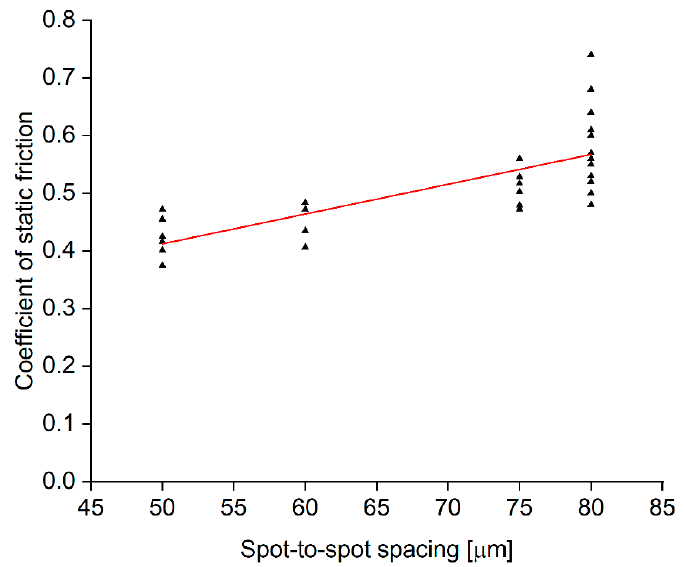
Figure 12. Static friction coefficient as a function of spot-to-spot spacing. The results presented here were obtained with both the 20 W and 200 W lasers. The results for the same spot-to-spot spacing are for a range of different crater depths, hence the spread of coefficient of friction values.